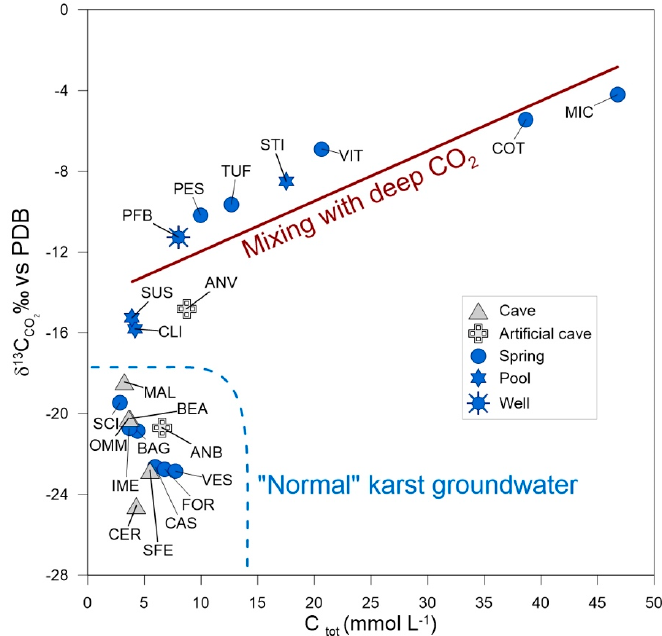
Figure 9. δ 13 C of CO 2 in equilibrium with the total dissolved inorganic carbon (TDIC) plotted vs total C content of the samples.